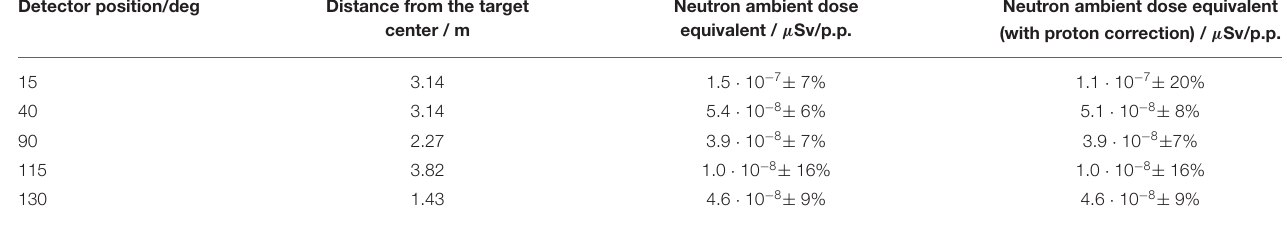
TABLE 1 | The neutron ambient dose equivalent per primary particle (p.p.) measured at the different dosimeter positions (reported distances are calculated from the center of the target center to the center of the dosimeters) are reported together with the measurement values corrected by the contribution of neutrons produced by the interaction of the secondary proton field with the dosimeter moderator (correction applied only to the two smallest angles). Detector position/deg Distance from the target Neutron ambient dose Neutron ambient dose equivalent center / m equivalent / µ Sv/p.p. (with proton correction) / µ Sv/p.p.